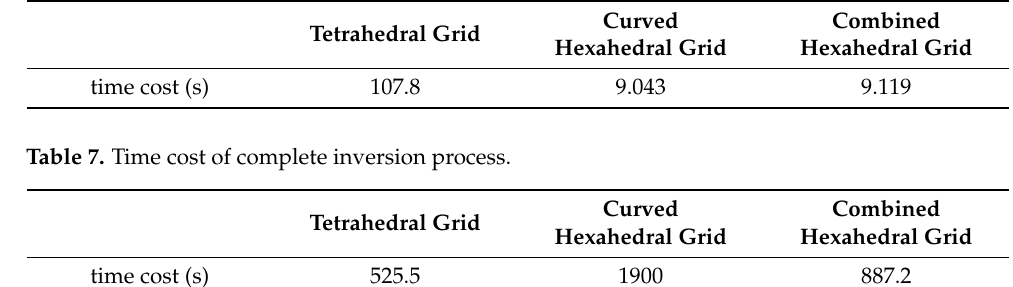
Table 6. Time cost of 1000 calculations of cross-gradient correlation terms.